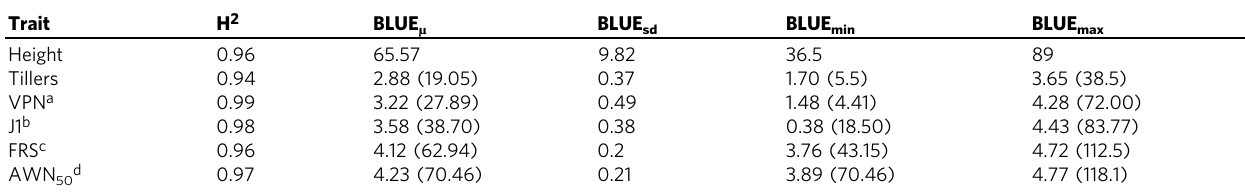
Mean (BLUE µ ), standard deviation (BLUE sd ), minimum (BLUE min ), and maximum (BLUE max ) of best linear unbiased estimates (BLUE) and reliability (H 2 ) of the phenotypic traits measured in the greenhouse. a Days to fi rst visible panicle. b Days to fi rst visible joint. c Days to fi rst ripe seed. d Days to 50% ripe